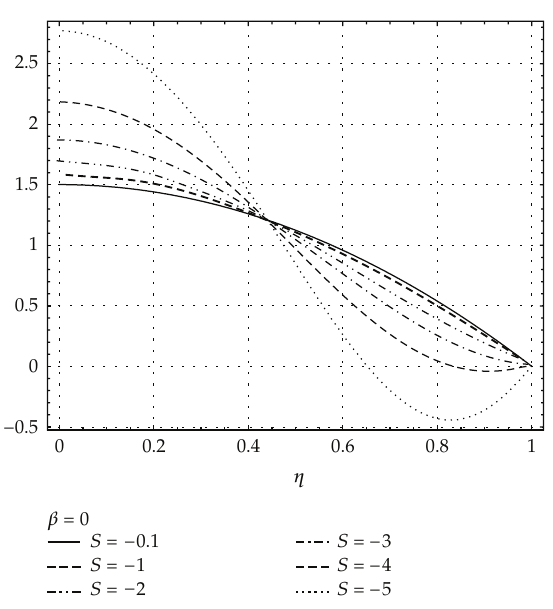
Figure 3: The influence of negative S on f (cid:2) (cid:3) η (cid:4) for the axisymmetric case.